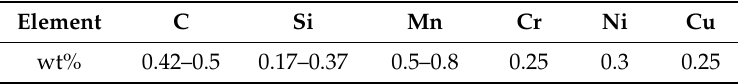
Table 2. Chemical composition of the 1045